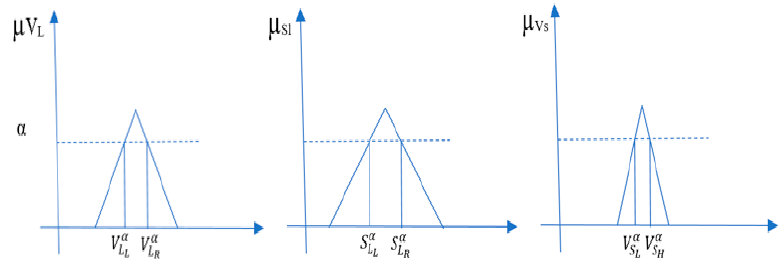
− cut of the fuzzy variables of source voltage, load bus voltage and load Figure 4. 𝛼 − 𝑐𝑢𝑡 of the fuzzy variables of source voltage, load bus voltage and load power. Figure 4. α